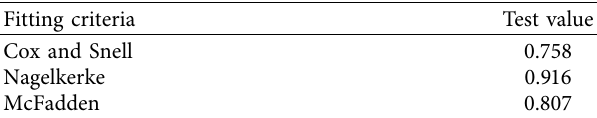
Table 6: Pseudo R -squared.